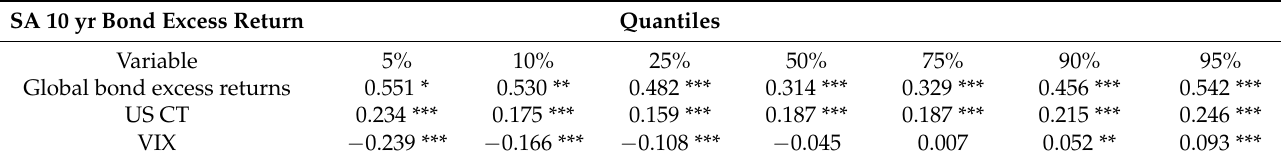
Table 8. Bond market results analysis (US carry